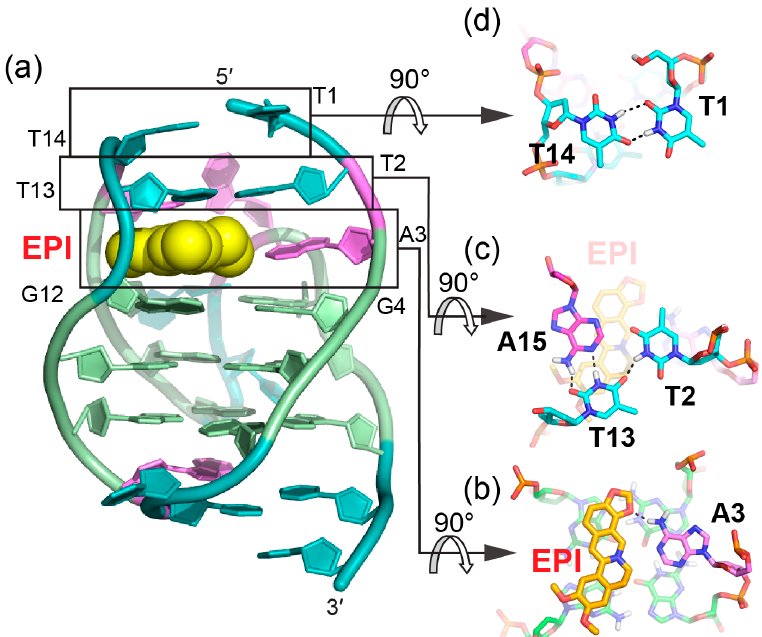
Figure 4. The specific recognition of human hybrid-2 telomeric G-quadruplex by EPI (PDB ID: 6CCW) ( a ) Cartoon representation of 1:1 EPI / hybrid-2 complex. Di ff erent nucleotides are marked as follows: Thymine, cyan; adenine, pink; and guanine, green. The EPI molecule is shown as the yellow spheres. ( b – d ) Top view of the EPI:A3 quasi-triad plane ( b ), T2:T13:A15 triad plane ( c ), and T1:T14 pair ( d ). Potential hydrogen bonds are shown in black dashed lines.